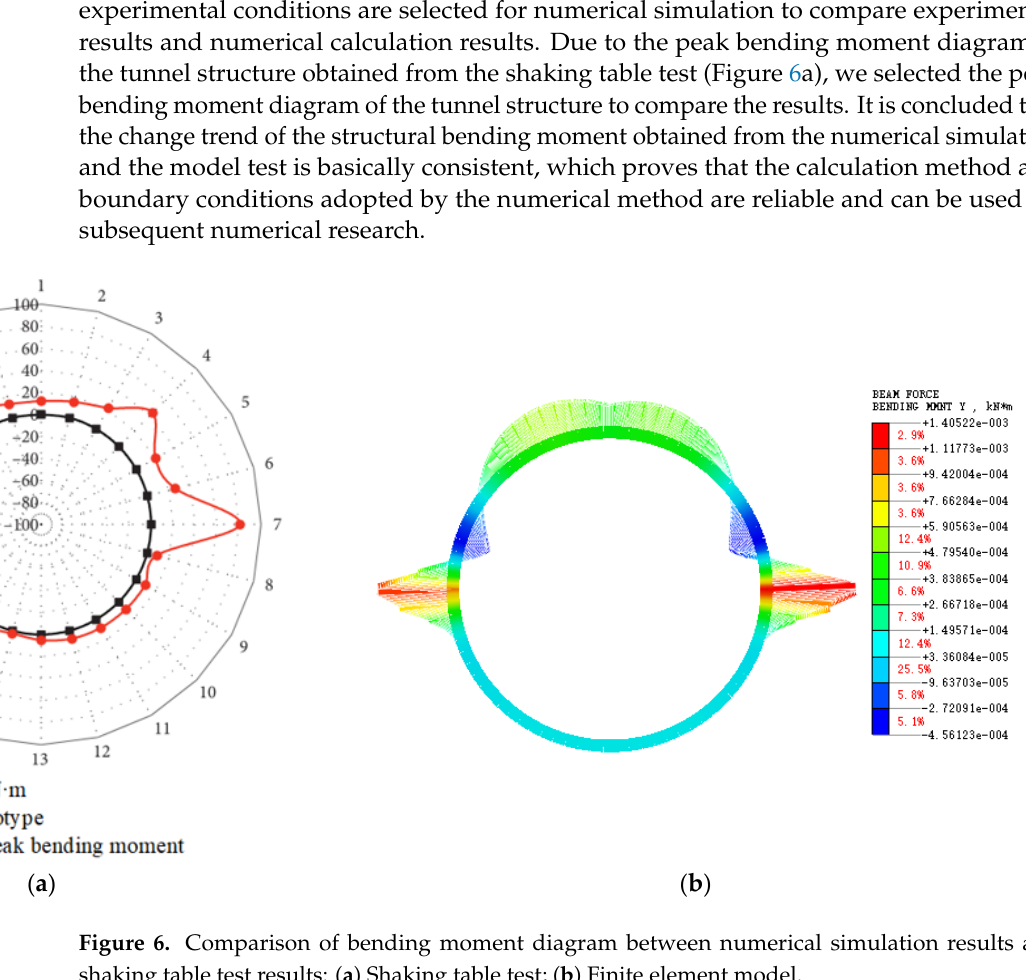
Figure 5. Schematic Diagram of Shaking Table Test and Numerical Simulation: ( a ) Shaking table test; ( b ) Finite element model.